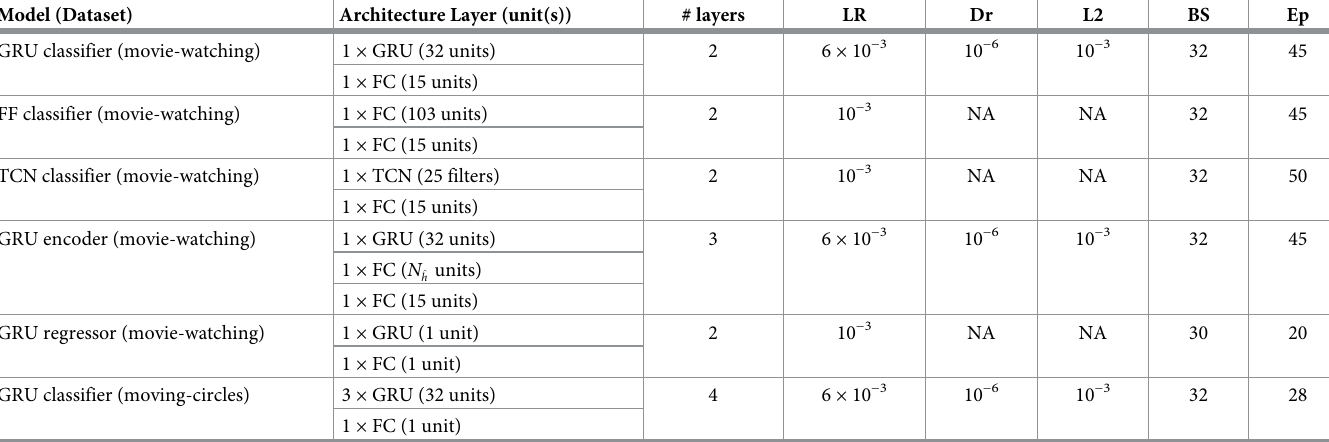
Table 1. Summary of models implemented in the paper. Hyperparameters and other parameters: LR : controlled the rate of update for gradient descent; Dr: dropout for the GRU layer [53]; L2 : L2 regularization coefficient for the GRU layer; BS : Batch Size, number of training samples before updating model parameters; Ep : Epochs, num- ber of passes through the training